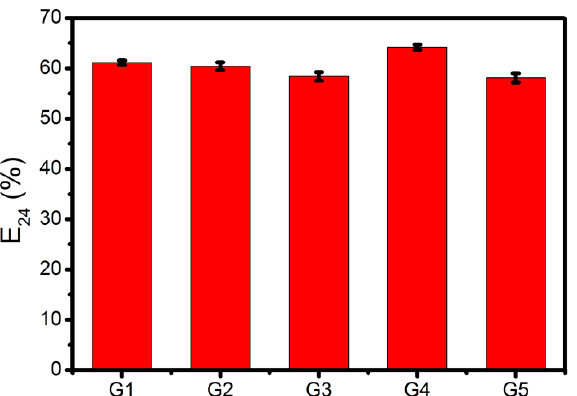
Figure 2. Emulsifying activity (E 24 , %) against n-hexadecane of cell-free supernatants obtained from cultures of Bacillus subtilis #309 grown in mineral salt medium (MSM) supplemented with glycerol from different sources (G1, G2, G3, G4 or G5). The results represent the mean ± standard deviation of three independent experiments performed in triplicate.